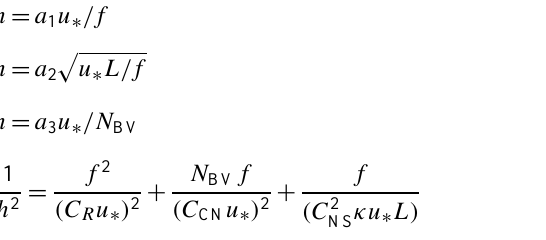
Fig. 10. Bar plot of friction velocity ( u ∗ ) and mean wind speed ( U) according to groups which are categorized based on the spectral shapes for crosswinds and temperature, and conformity with N BV . Open white bars represent friction velocity and gray bars denote mean wind speed.